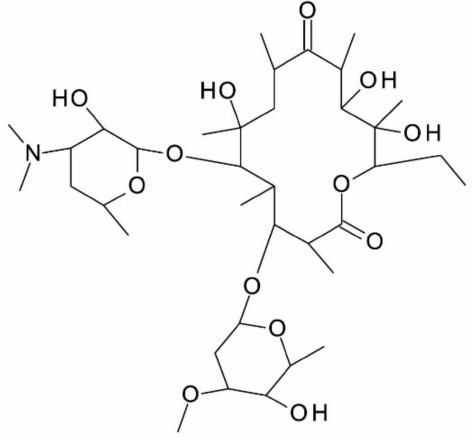
Figure 6. Chemical structure of